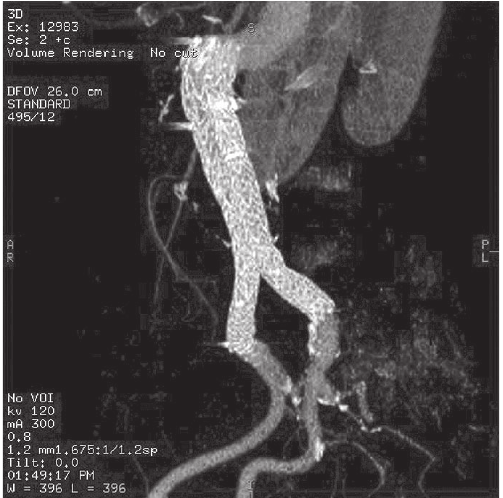
Fig. 3 - Tomografia computadorizada de controle após correção endovascular com endoprótese bifurcada, em paciente com AAA e colo angulado.